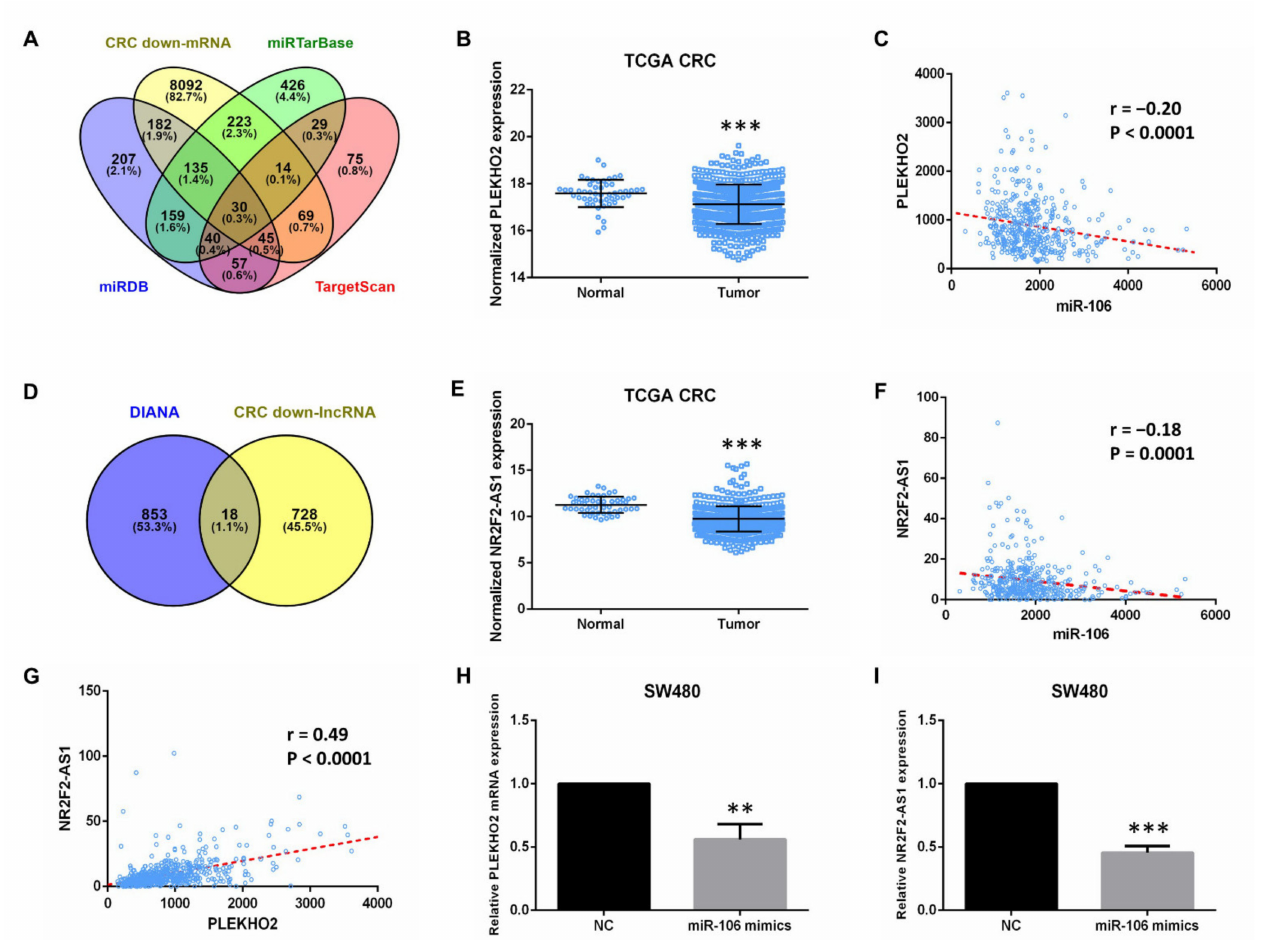
Figure 4. Bioinformatic analyses predict the target of miR-106b. ( A ) The Venn diagram represents the number of miR-106b target mRNAs predicted by miRTarBase, TargerScan, miRDB and down-regulated mRNAs in CRC from TCGA dataset. ( B ) The expression of PLEKHO2 in normal colorectal tissues and CRC from TCGA. ( C ) Pearson’s correlation analysis revealed the expression of PLEKHO2 is negatively correlated with miR-106b in CRC tissues. ( D ) The Venn diagram represents the number of miR-106b target lncRNAs predicted by DIANA and down-regulated lncRNAs in CRC from TCGA dataset. ( E ) The level of NR2F2-AS1 in normal colorectal tissues and CRC from TCGA. ( F ) Pearson’s correlation analysis revealed the level of NR2F2-AS1 is negatively associated with miR-106b in CRC tissues. ( G ) The expression of PLEKHO2 is positively correlated with NR2F2-AS1. ( H , I ) Transfection of miR-106b mimics in SW480 cells inhibits the expression of PLEKHO2 and NR2F2-AS1. All data are shown as the mean ± SD, ** p < 0.01, *** p <